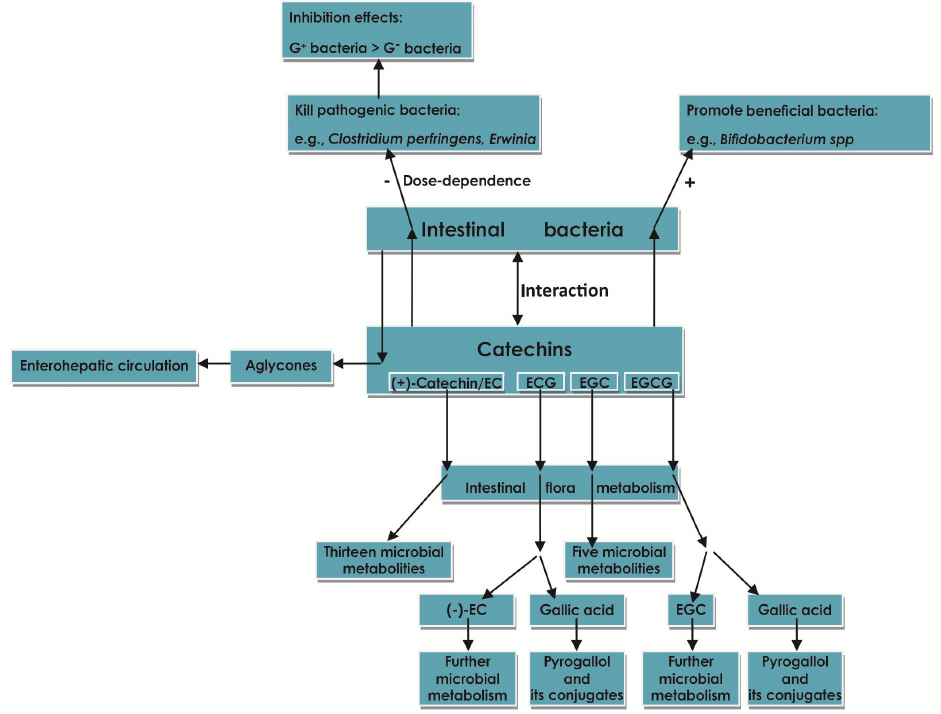
Figure 8. The interaction between catechins and intestinal microflora.